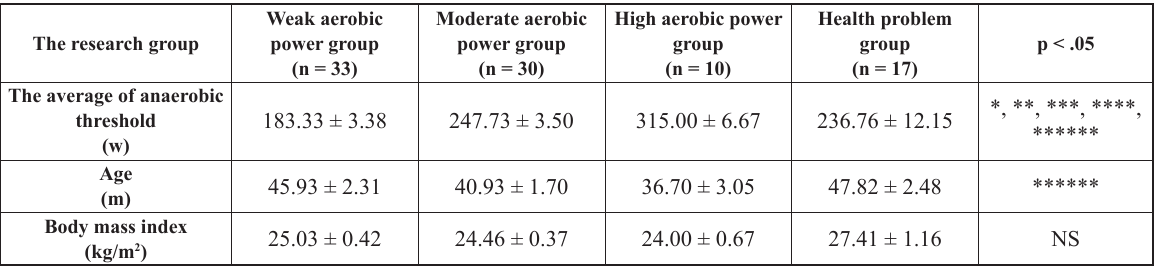
Note. * – statistical difference between WAPG and MAPG, ** – statistical difference between WAPG and HAPG, *** – statistical difference between WAPG and HPG, **** – statistical difference between MAPG and HAPG, ***** – statistical difference between MAPG and HAPG, ****** – statistical difference between HAPG and HPG; NS – no significant